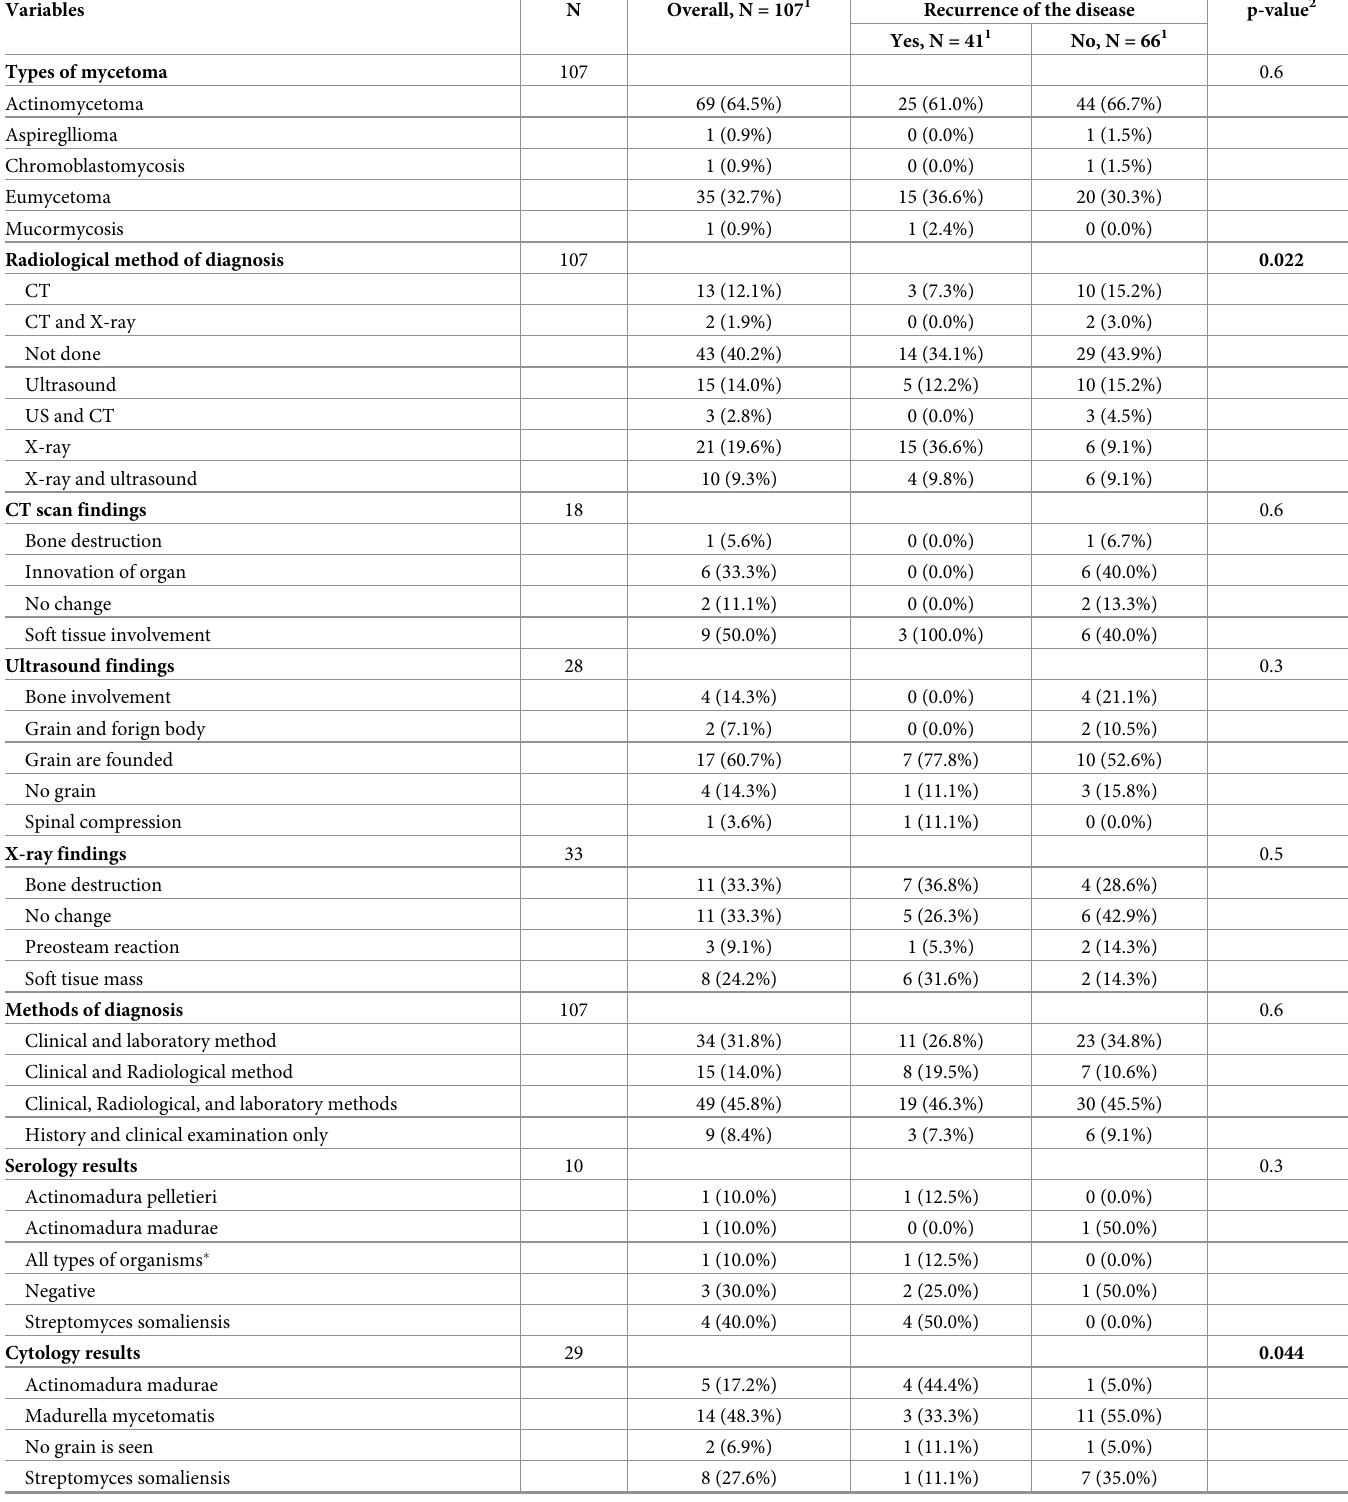
Table 4. Diagnostic findings in patients with head and neck mycetoma. (n =